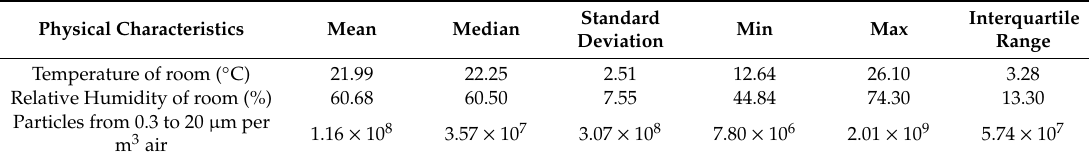
Table 2. Physical characteristics of bioaerosols from the 48 mold-damaged houses.